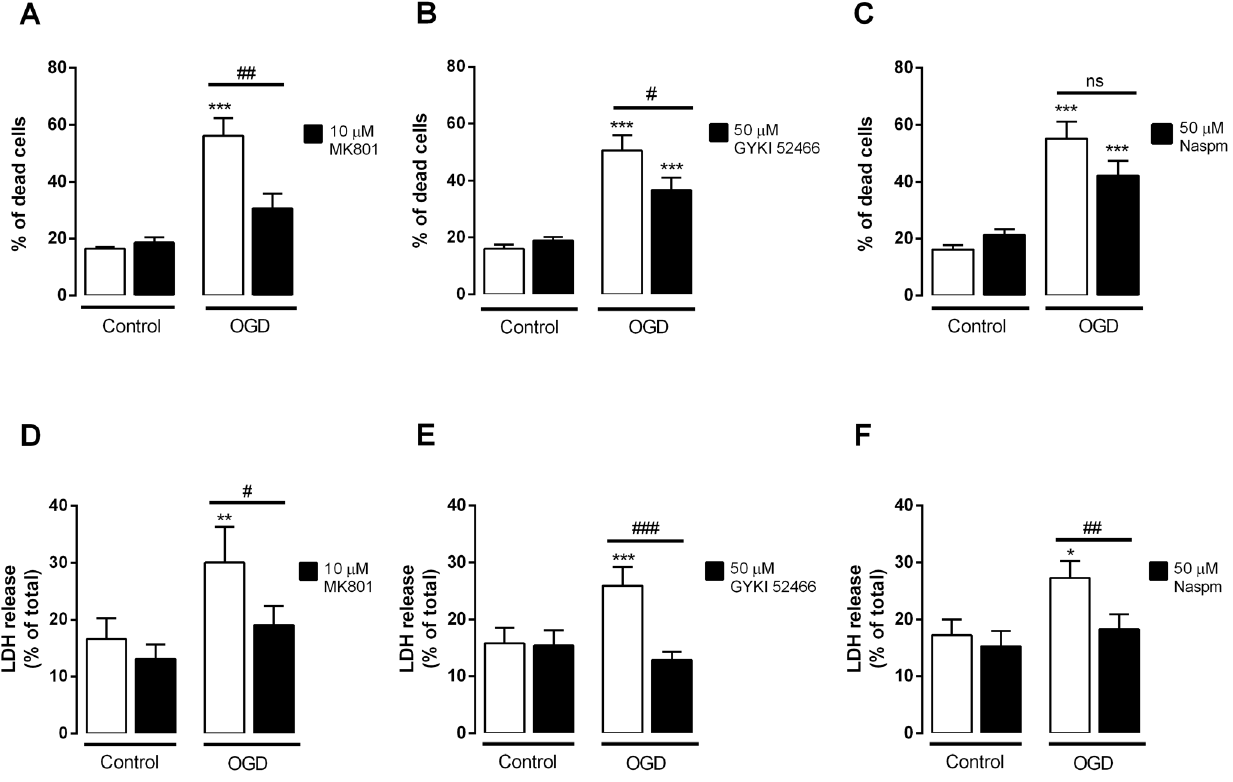
Figure 2. Inhibition of glutamate receptors protects hippocampal neurons against OGD-induced cell death. Mature hippocampal neurons were subjected to 2 h OGD in the absence or presence of glutamate receptor antagonists. When present, the antagonists were added 15 min prior to stimulation and kept during the stimulation and post-stimulation periods. Cell viability was assessed 24 h after the stimulus by analysis of the nuclear morphology ( A–C ) and by determination of the LDH release ( D–F ). Bars represent the mean 6 SEM of 4–9 independent experiments, performed in distinct preparations. Statistical analysis was performed using One-way ANOVA followed by Bonferroni’s Multiple Comparison Test: * p , 0.05, ** p , 0.01, *** p , 0.001, relative to control; # p , 0.05, ## p , 0.01, ### p , 0.001 relative to OGD condition. MK-801, selective NMDAR antagonist; GYKI 52466, selective AMPAR antagonist; Naspm, selective CP-AMPAR antagonist.